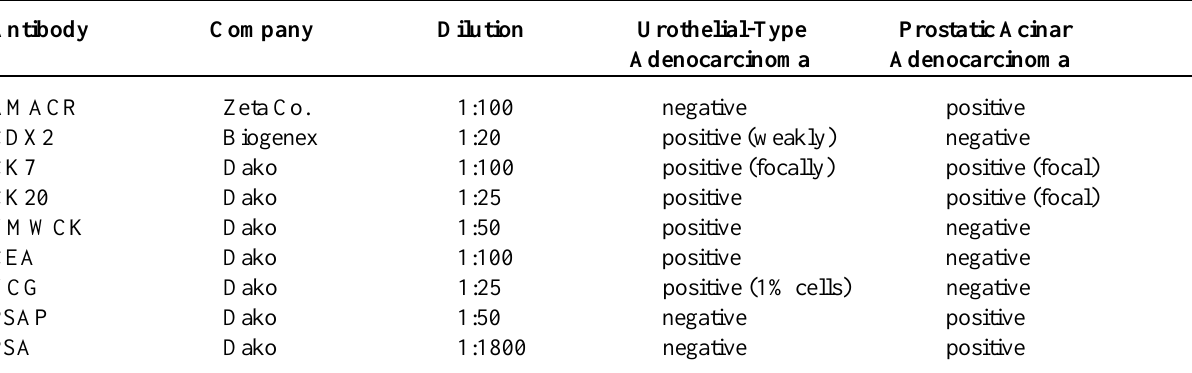
Table 1 – Summary of immunohistochemical results for urothelial-type adenocarcinoma and prostatic acinar adenocarcinoma.